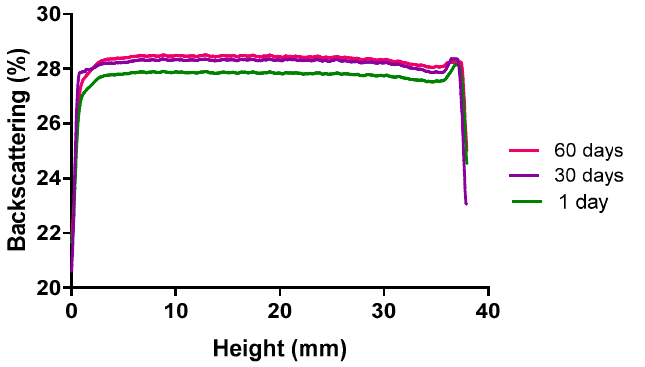
Figure 8. Backscattering of the PF-NLCs-N6 at different stability time points stored at 25 °C ( n = 3). The left side of the curve represents the bottom of the vial, and the right side is the behaviour in the upper part of the vial.